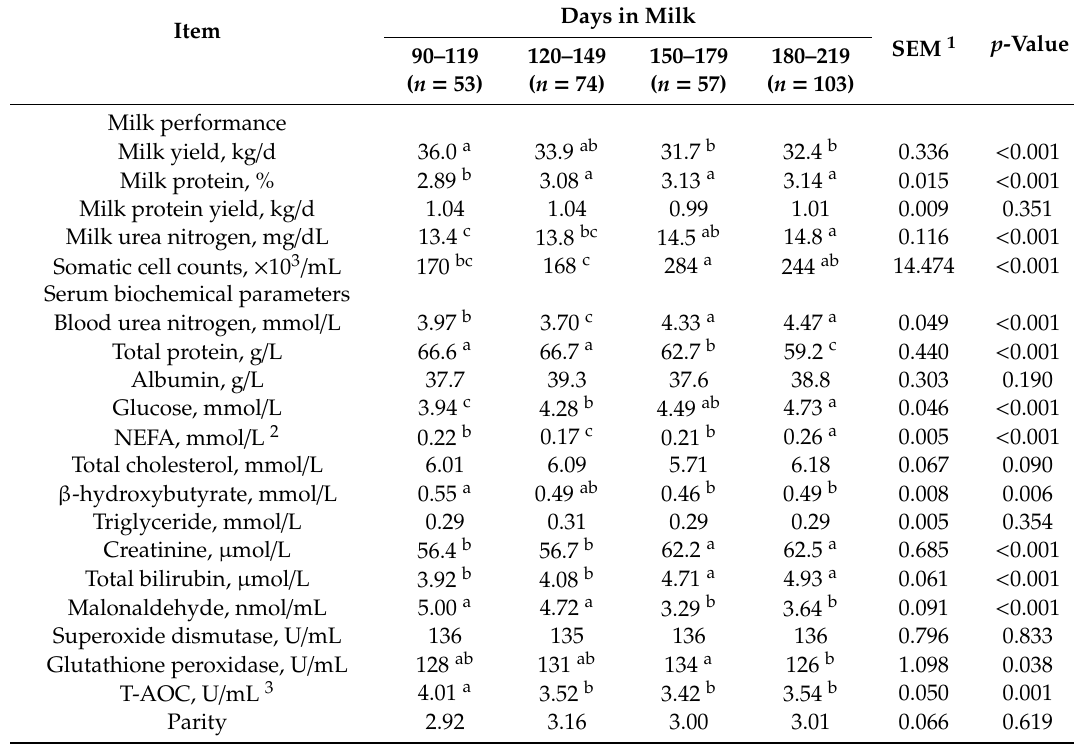
Table 1. E ff ects of days-in-milk on milk performance and blood biochemical parameters.